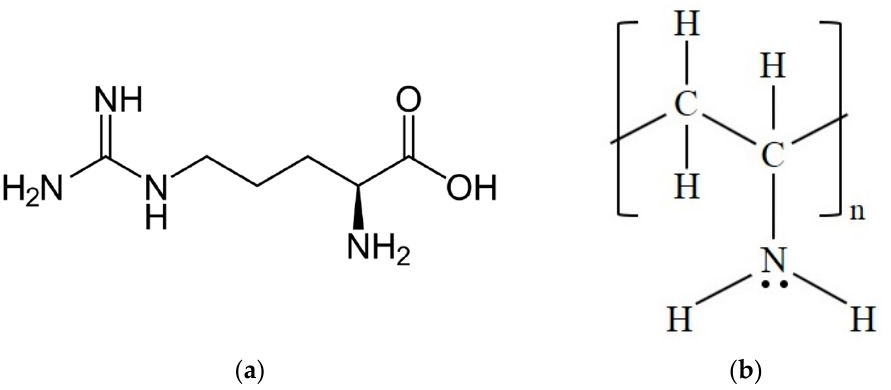
Figure 1. Chemical structure of ( a ) L-arginine and ( b ) (neutral) PVAm.